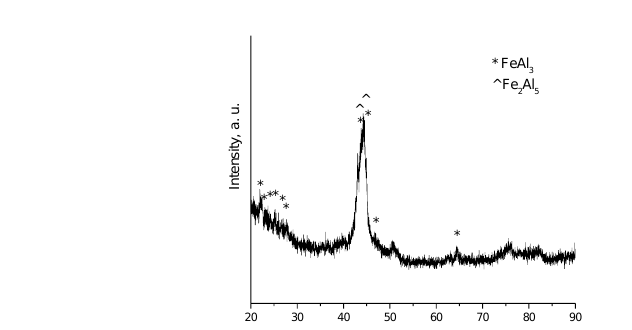
Figure 6. Fracture surface of the material obtained by SPS of Al – 70 vol.% Fe 66 Cr 10 Nb 5 B 19 , ( a , b ) different magnifications. Al powder 10 – 45 μm. SPS conditions: temperature— 570 °C, holding time — 20 min, applied pressure — 40 MPa. BSE images.